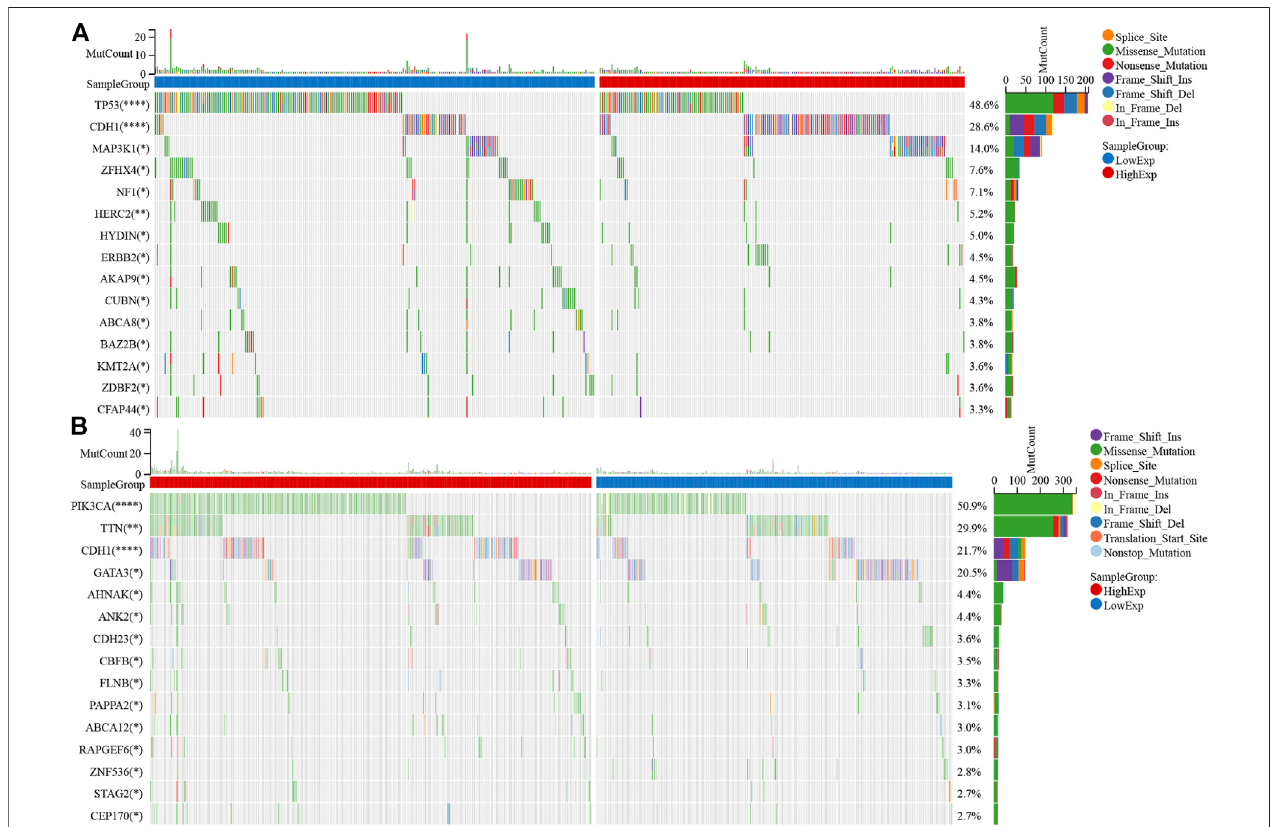
FIGURE 6 | UCPs and mutational landscape. Comparison of the mutational landscape between groups with high- and low- (A) UCP1 and (B) UCP2 expression. Differences in gene mutation frequency were analyzed by chi-square test. * p < 0.05; ** p < 0.01; *** p < 0.001; **** p < 0.0001.